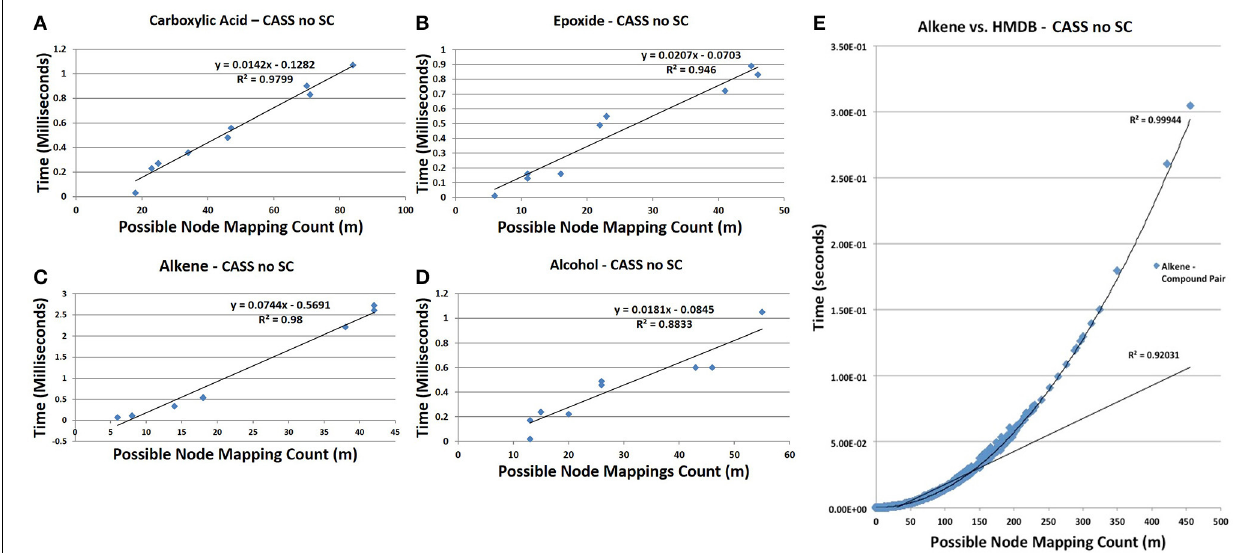
FIGURE 9 | Time trials for CASS with no short circuiting. (A) The time needed to find carboxylic acids is pseudo-linear at m < 100 ( R 2 = 0 . 9799). (B) Similar to carboxylic acids, the time needed to find epoxides is pseudo-linear for observed m , ( R 2 = 0 . 946). (C) Similarly, the time needed to search for alkenes grows pseudo-linearly with m ( R 2 = 0 . 98). (D) The time needed to find alcohols remains low at all observed values of m but is less strongly linear than with other functional groups ( R 2 = 0 . 8833). It is likely that with respect to high values of m , all functional groups would show polynomial growth; however, for most values compounds, m will be sufficiently small to allow our algorithm to show pseudo-linear performance. (E) The time needed to find all alkenes in the HMDB demonstrates the non-linear performance of CASS for values of m > 150, as the overall trend matches a second-order polynomial with an R 2 of 0.9994. Although non-linear, the time needed grows slowly enough to allow all functional group searches to complete in a